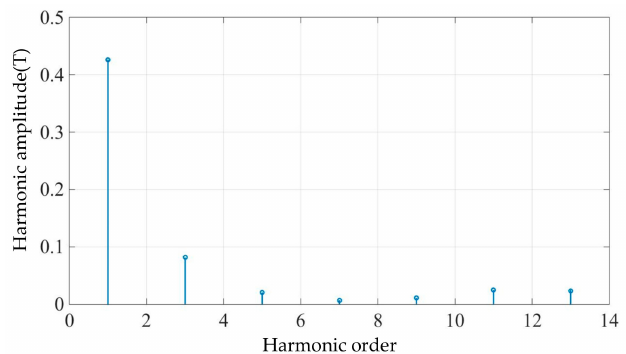
Figure 6. Harmonic distribution of air gap tangential flux